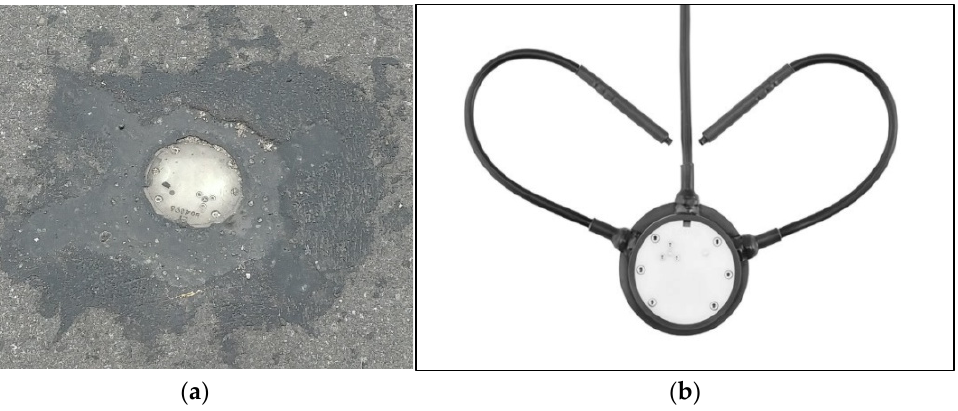
Figure 4. IRS31 pro-UMB intelligent passive road-surface temperature sensor. ( a ) Embedded sensor in the asphalt along the bridge section of entry North. ( b ) Overview of the passive temperature sensor.